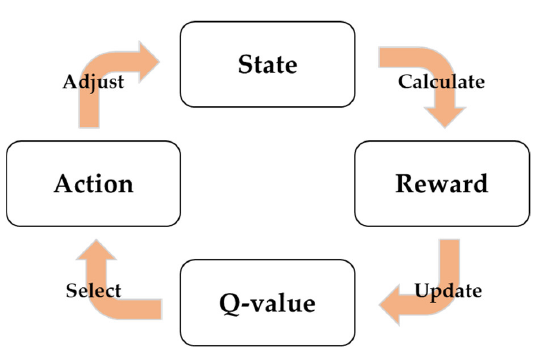
Figure 10. Schematic of Q-learning [26].